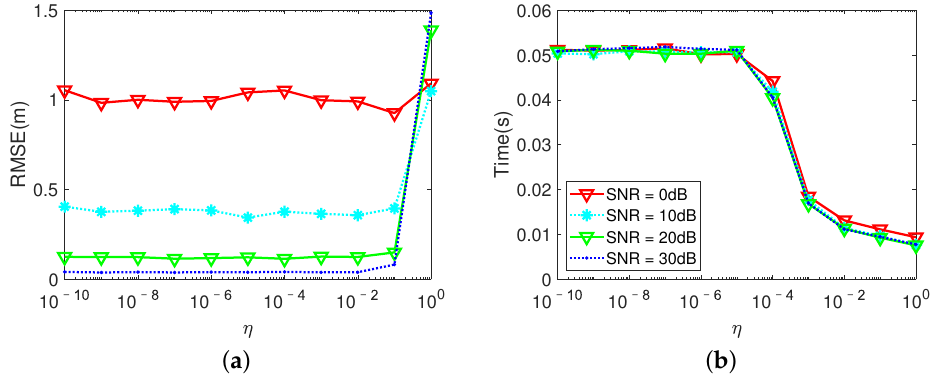
Figure 20. Performance of Tomo-ANM-IVDST under different stopping criterion η and SNRs. ( a ) Location accuracy. The legend is the same as in ( b ). ( b ) Time